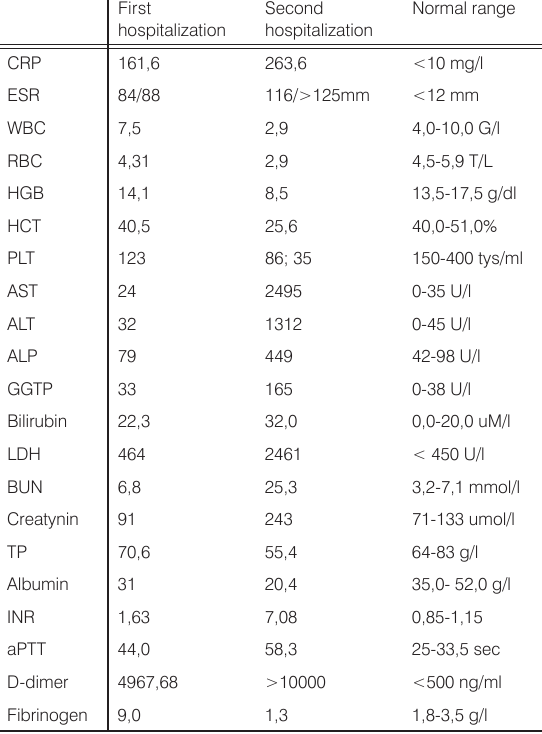
Table 1. Laboratory test results of the patient during 1 st and 2 nd hospitalization.